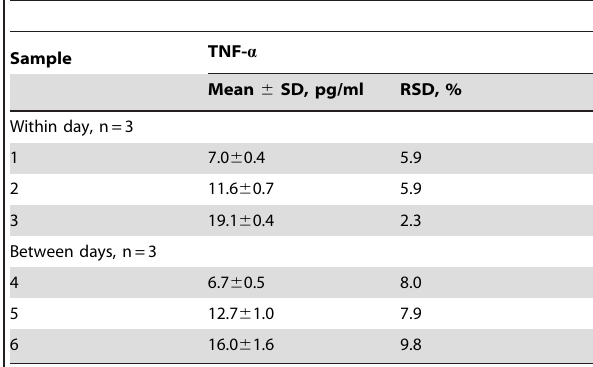
Table 6. Reproducibility of microchip method for the determination of TNF- a in plasma